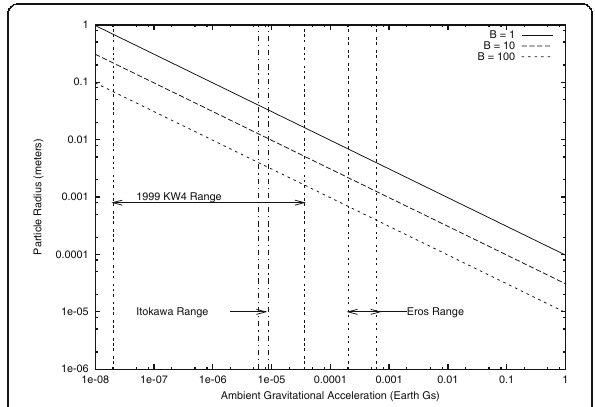
Fig. 16 Bond numbers as a function of particle radius and gravitational acceleration (from Scheeres et al. 2010). Ryugu ’ s ambient gravity is estimated of the order of 0.25 m